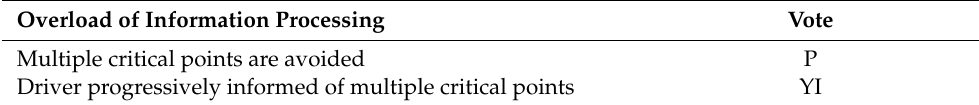
Table 14. Evaluations of the “overload of information processing” investigation topic. Overload of Information Processing